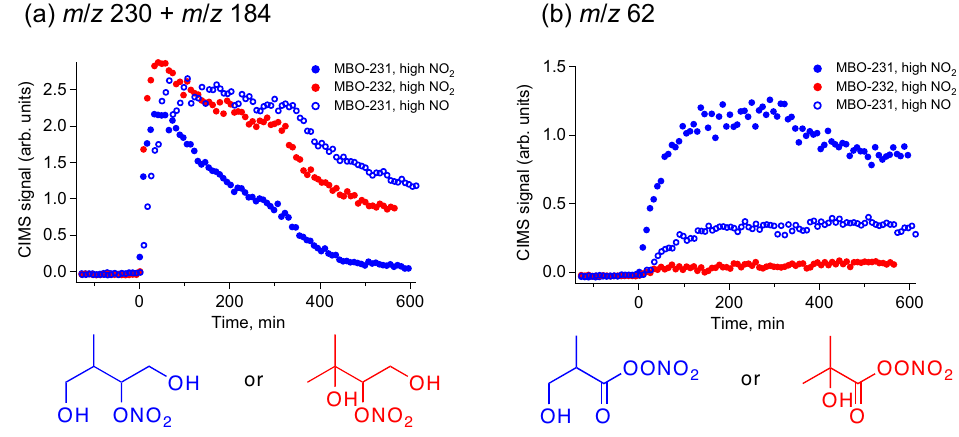
Fig. 16. Gas-phase ion signals of C 4 -hydroxy-PAN and C 5 -dihydroxynitrate from photooxidation of MBO231 and MBO232, as ob- served by negative chemical ionization-tandem mass spectrometry of m/z 250. Neutral losses of HF or CF 2 O are associated with the C 5 -dihydroxynitrate under CID of the parent ion m/z 250, leading to daugher ions of 230 and 184, respectively. The daughter ion m/z 62, most likely NO − , is associated with the C 4 -hydroxy-PAN. (See Supplementary Material for more details.) After 300 minutes of irradia- 3 tion, more OH precursor was added to further react oxidation products. PAN formation was observed only from MBO231 oxidation and is positively correlated with NO 2 /NO, similar to unsaturated